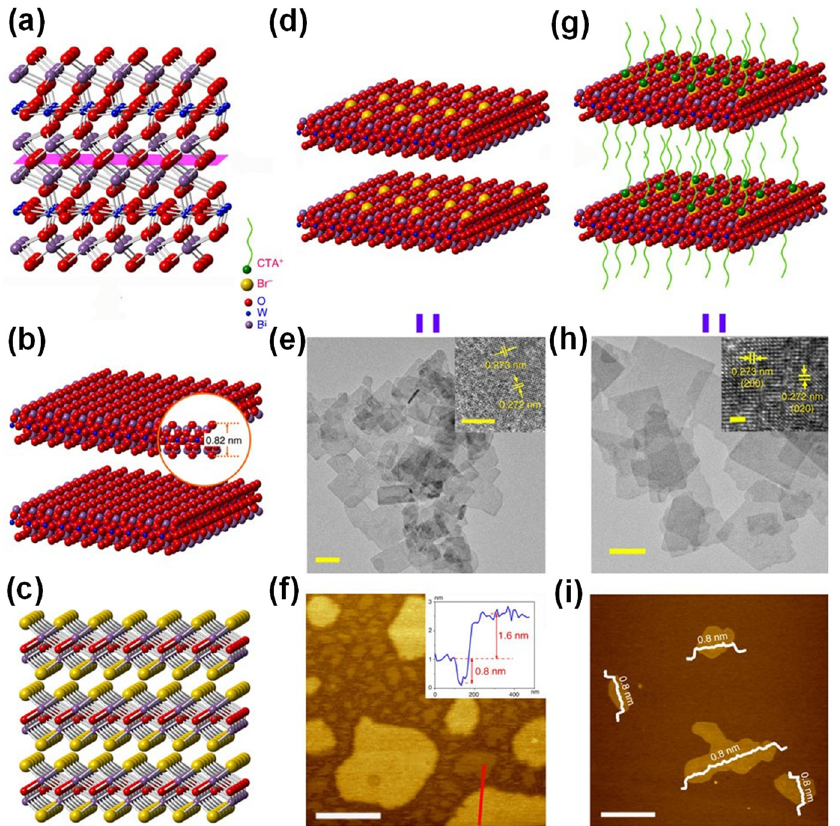
Figure 4. ( a ) Crystal structure of Bi 2 WO 6 ;( b ) Structure of pristine monolayer Bi 2 WO 6 ; ( c ) Crystal structure of BiOBr; ( d ) Formation mechanism of the monolayer Bi 2 WO 6 with Br-ions assistance; ( e ) TEM and ( f ) AFM image of the Bi 2 WO 6 nanosheets with Br − ions assistance, respectively; ( g ) Growth mechanism of the monolayer Bi 2 WO 6 photocatalyst with CTAB assistance; ( h ) TEM and ( i ) AFM image of the monolayer Bi 2 WO 6 photocatalyst with CTAB assistance. Scale bar, 500 nm ( f , i ), 50 nm ( e , h ), 5 nm (insets in ( e )) and 1 nm (insets in ( h )) [34]. Copyright 2015, Nature Publishing Group.